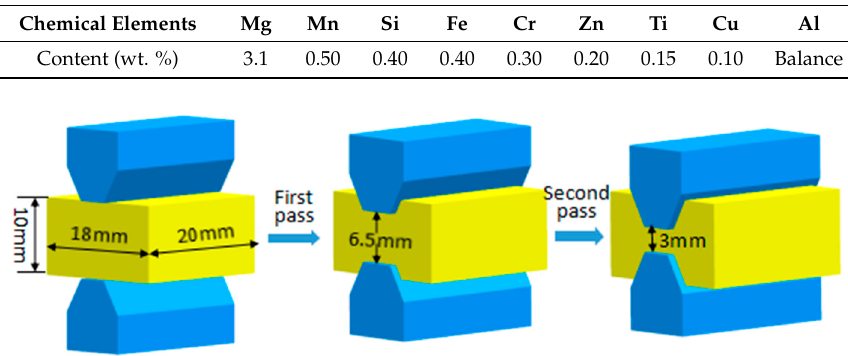
Table 1. Chemical elements and content of 5754 aluminium alloy.